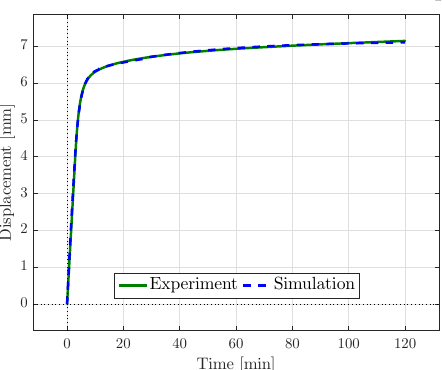
( a ) Tensile test—comparison of experimental and ( b ) Relaxation test—comparison of experimental and simulated material response.